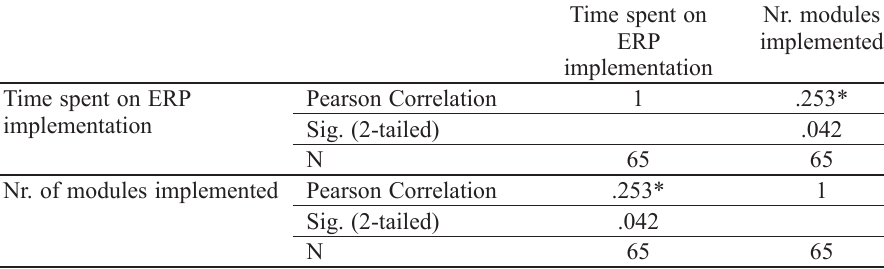
Table 7. Time spent on ERP implementation and modules implemented